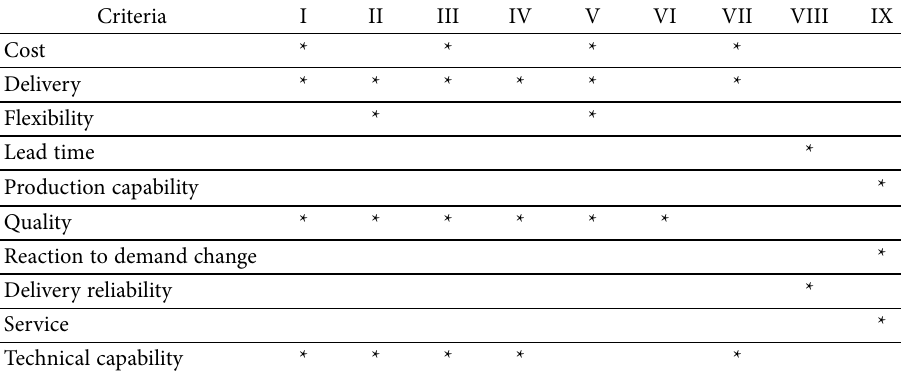
Table 1. Top 10 criteria used in the literature of supplier selection